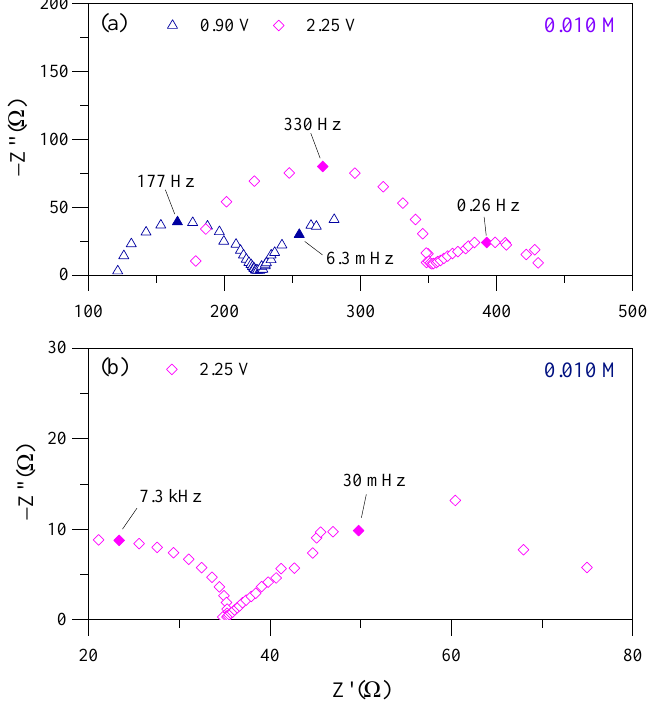
Figure 7. Electrochemical impedance spectroscopy spectra obtained at bias potentials corresponding the i = i lim,2 (blue) and i > i lim,2 (pink) for the ( a ) 0.01 M and ( b ) 0.1 M H x PO 4 3 − x solution at pH 7.2. For the 0.1 M solution, only i lim,1 was reported. Solid points refer to characteristic frequencies.